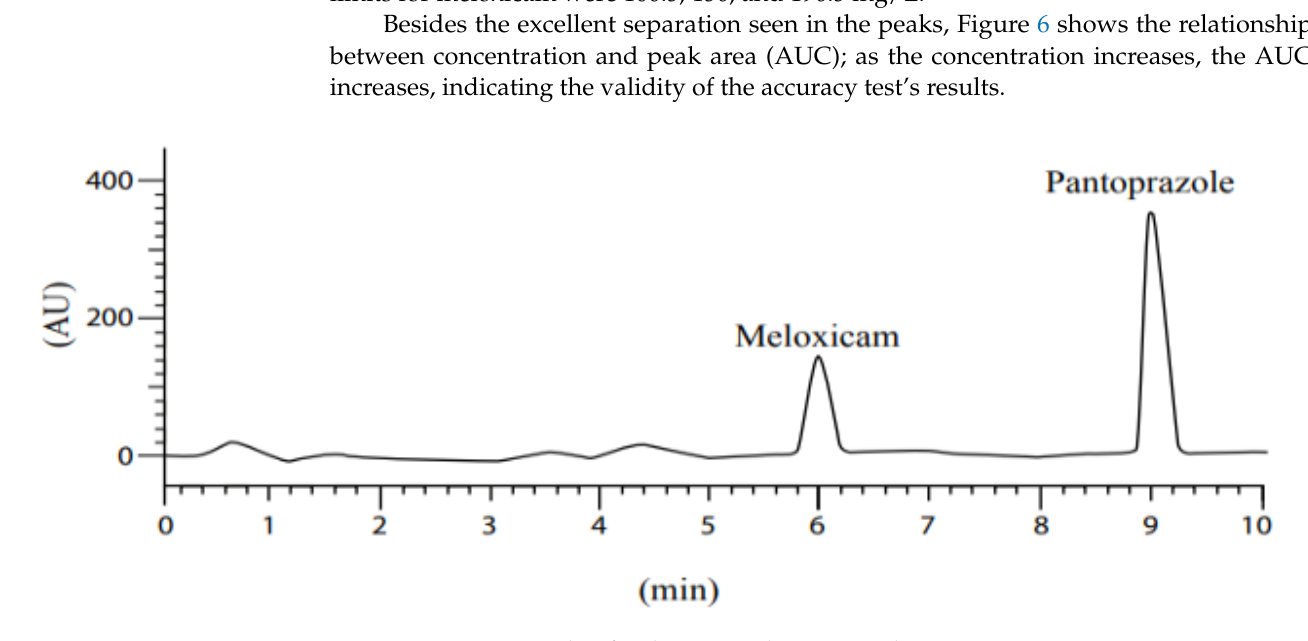
Figure 6 . Accuracy results of meloxicam and pantoprazole . Figure 6. Accuracy results of meloxicam and pantoprazole.